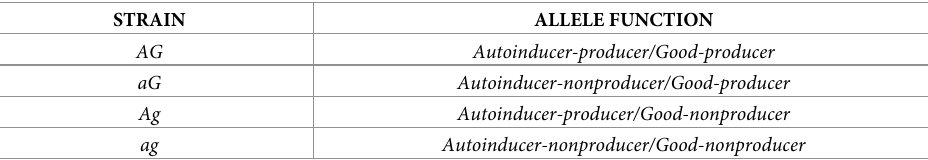
Table 1. Strain types and a description of their allele